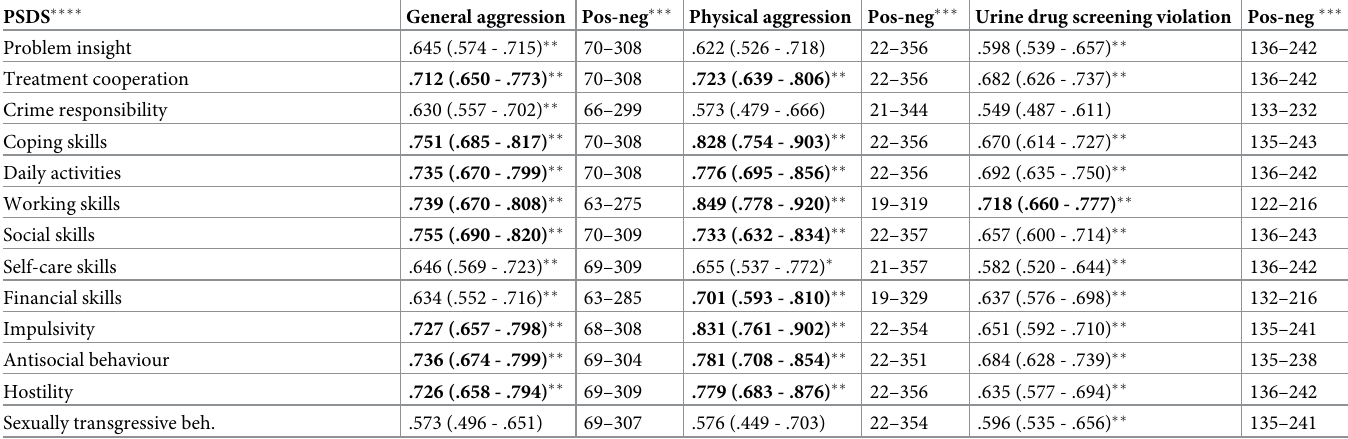
Table 6. AUCs for the co-morbid personality and substance use